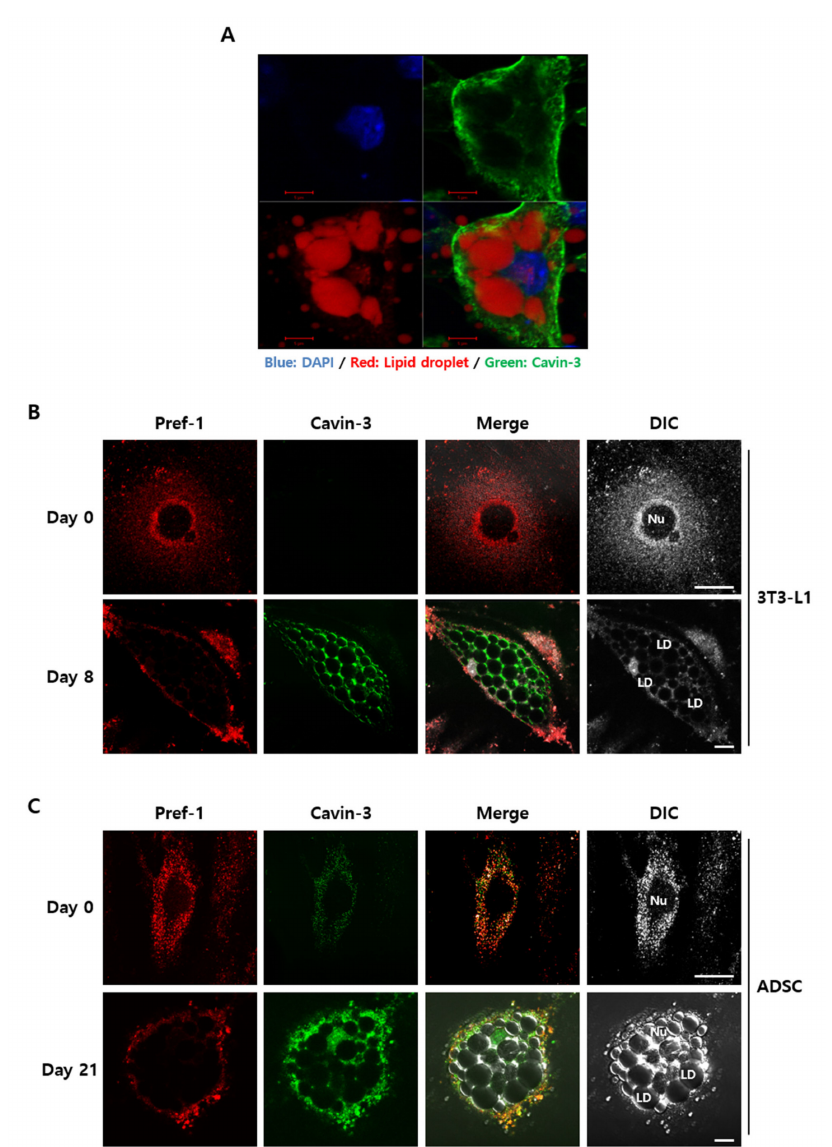
Figure 4. The exchange of Cavin-3 and Pref-1 subcellular localization during adipocytes di ff erentiation in 3T3-L1 and human adipose derived stem cells (ADSC). The cells were fixed and stained with specific antibodies, respectively. ( A ) The nucleus was stained with 4,6-diamidino-2-phenylindole (DAPI) (blue), lipid droplets were stained with Sudan III (red), and Cavin-3 were stained with anti-Cavin-3 (green) antibody at day 8 of di ff erentiation. ( B , C ) Normal 3T3-L1 adipocytes and human adipose-derived stem cells (ADSCs) were fixed with anti-Pref-1 (red) and anti-Cavin-3 (green) antibodies at each time point. Cells were imaged with a confocal microscope. Scale bar = 5 µ